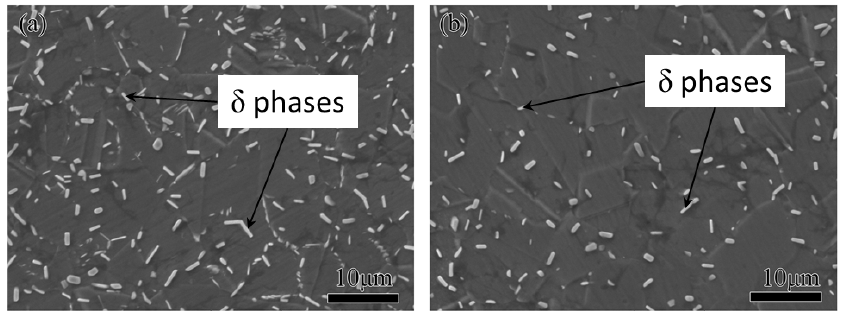
Figure 6. SEM image (secondary electronic signal) of δ phases [5] in the specimens heated at 960 ° C ( a ) and 990 ° C ( b ).